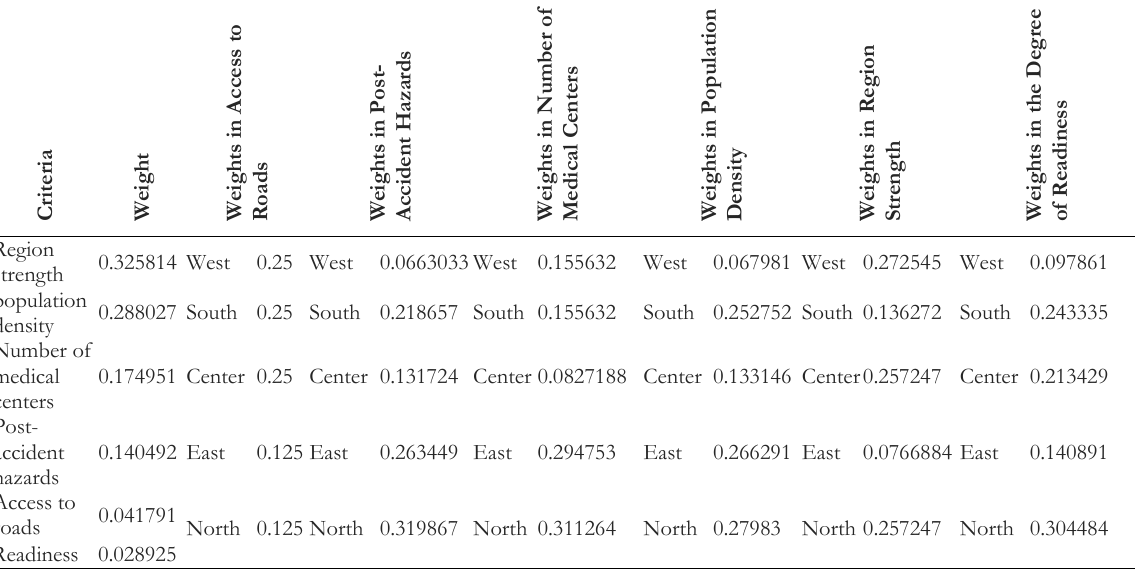
Table 6. Calculation of local weights.